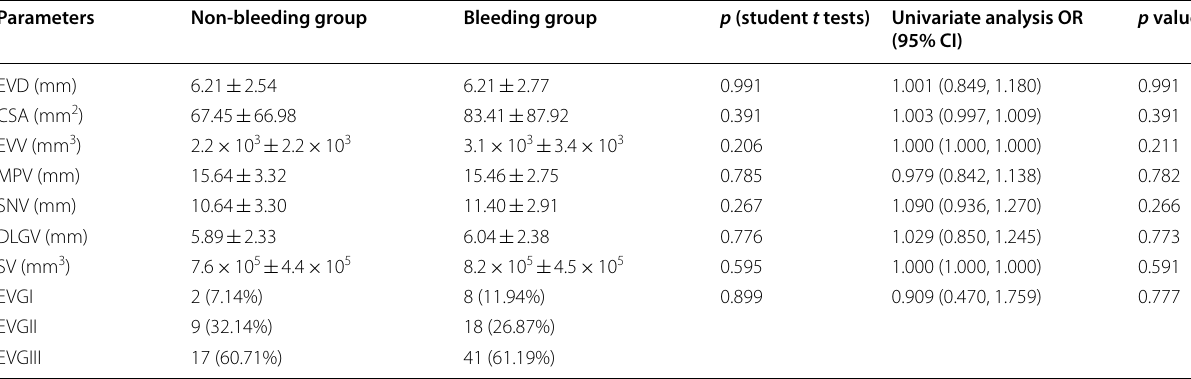
Parameters except EVG are expressed as mean